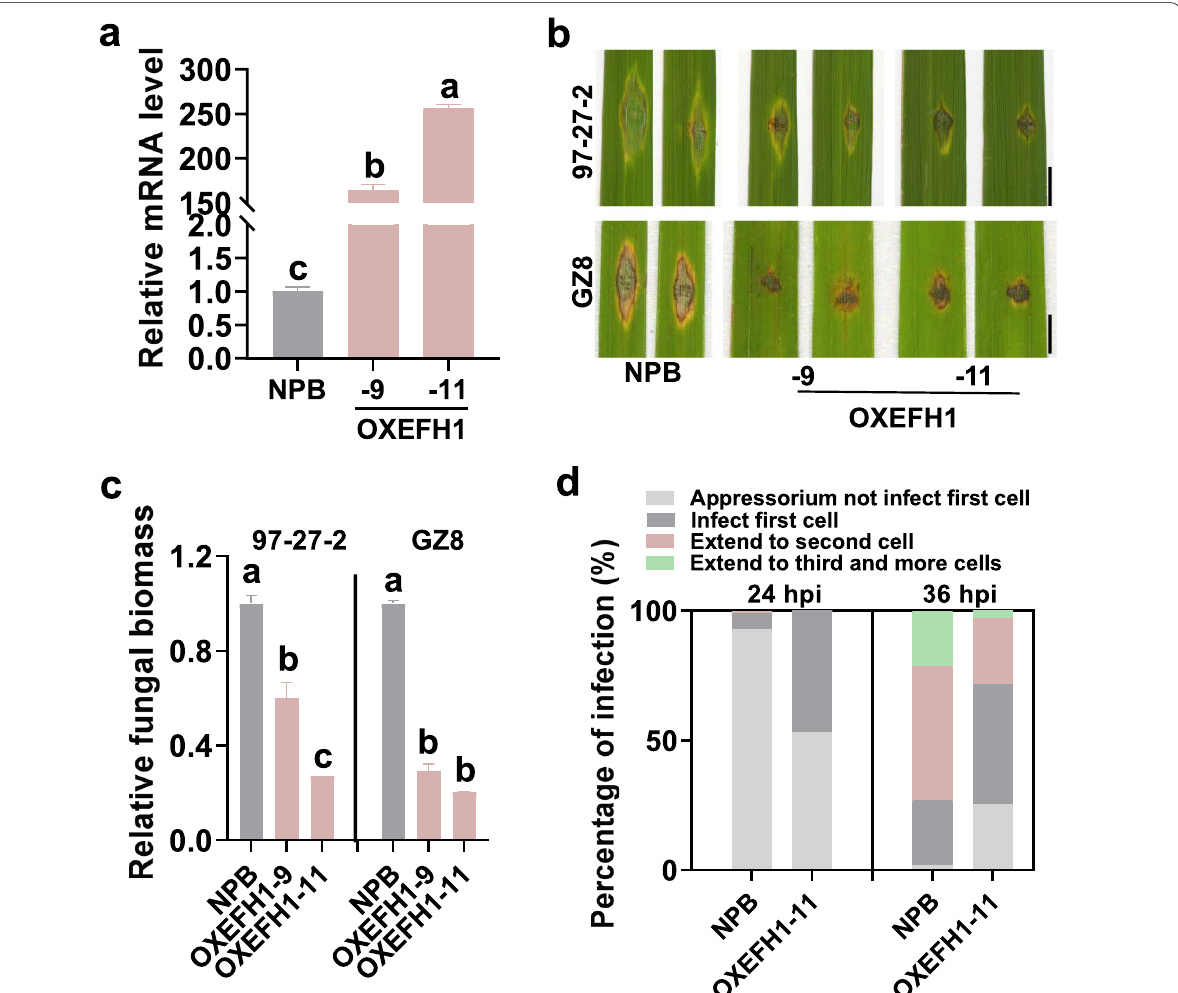
Fig. 4 OsEFH1 enhances rice blast disease resistance. a The relative mRNA levels of OsEFH1 in transgenic lines overexpressing OsEFH1 (OXEFH1) and the Nipponbare (NPB) control. Total RNA was extracted from three to five‑leaf stage seedlings for reverse‑transcription‑quantitative polymerase chain reaction (RT‑qPCR) analysis. The relative mRNA levels of OXEFH1 lines were normalized with that of the Nipponbare control. b The blast disease phenotypes of OXEFH1 lines and the Nipponbare control at 5 days post‑inoculation (dpi) of indicated M. oryzae strains. Bar 5 mm. c The = Quantification analysis of the relative fungal biomass in b . The fungal biomass was shown as the ratio of DNA level of M. oryzae MoPot2 genes against that of rice ubiquitin . d Quantification analysis of the fungal development during the invasive process. Over 200 conidia in each line were analyzed. For a and c , error bars indicate SD (n 3 independent samples). Different letters above the bars indicate a significant difference ( P < 0.01) = as determined by a one‑way Tukey–Kramer analysis. All the experiments were repeated two times with similar